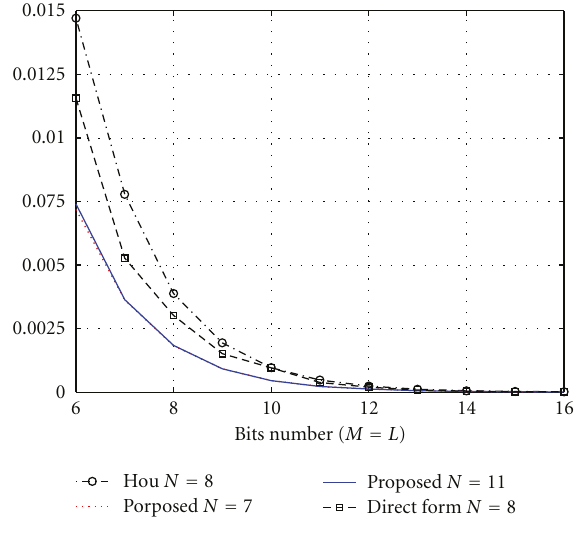
Figure 10: Mean square error.